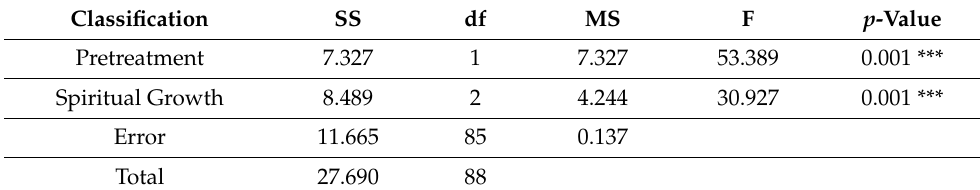
Table 6. The ANCOVA result of spiritual